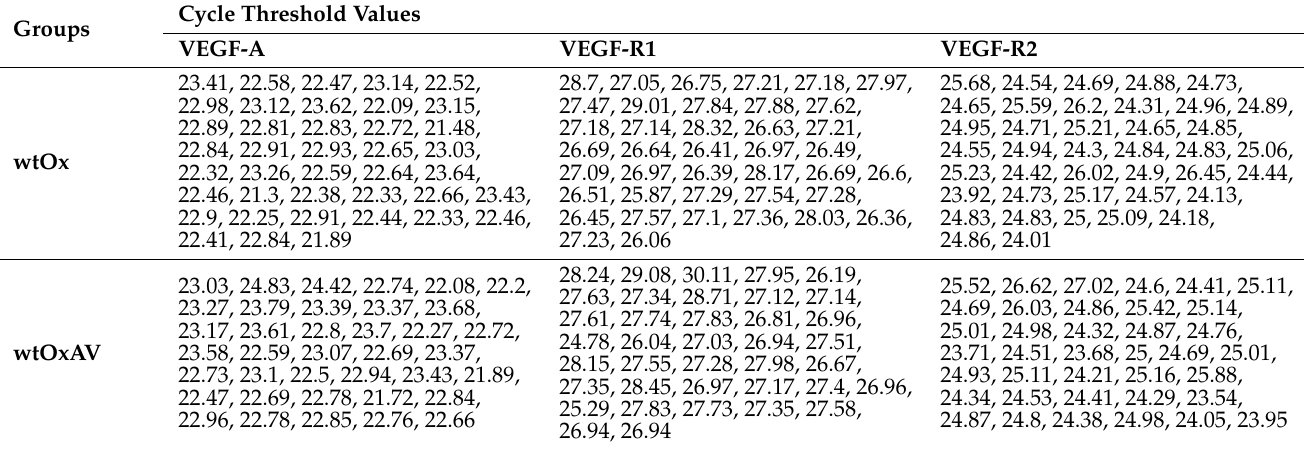
Table A1. Overview of cycle threshold values of quantitative PCR